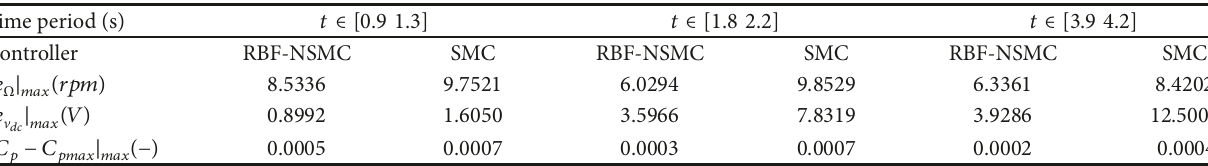
Table 3: Comparison of maximum deviations from the optimal curve under varying wind speed with parametric perturbations. Time period (s) 𝑡 ∈ [0.9 1.3] 𝑡 ∈ [1.8 2.2] 𝑡 ∈ [3.9